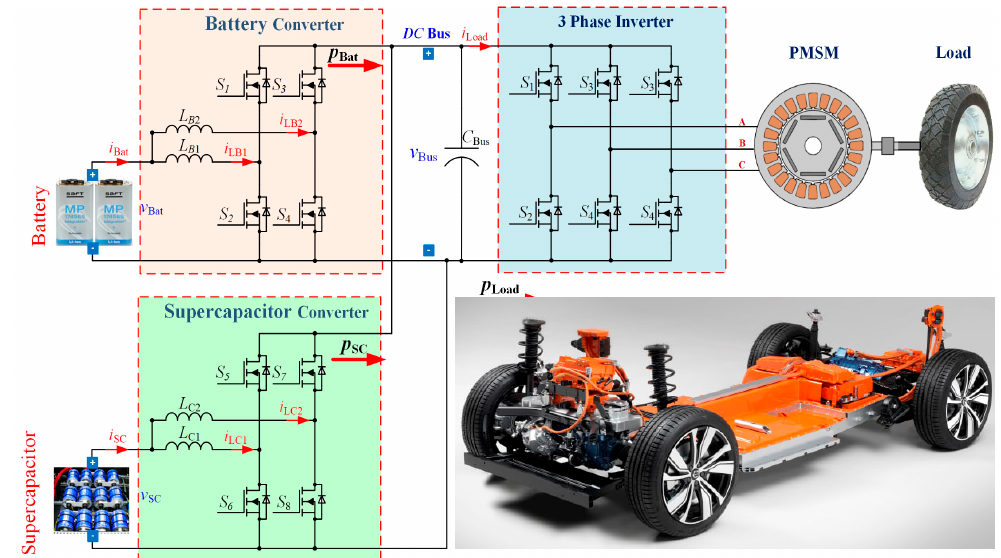
Figure 2. Proposed DC–DC converter circuits for e-Vehicle applications based on SC / battery hybrid power source.